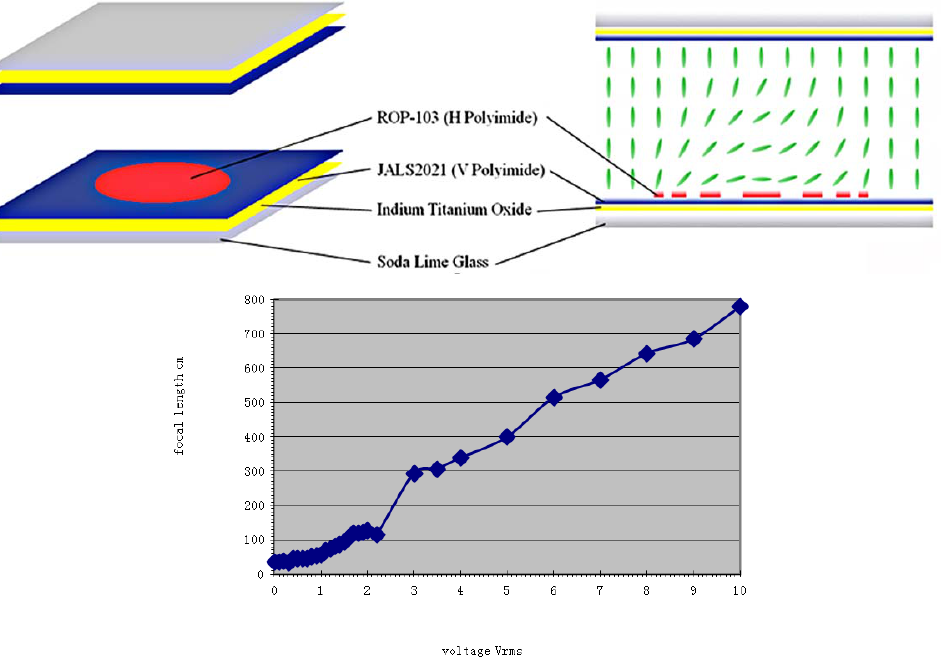
Figure 4. Electrically tunable LC lens, based on photoalignment technology [28].